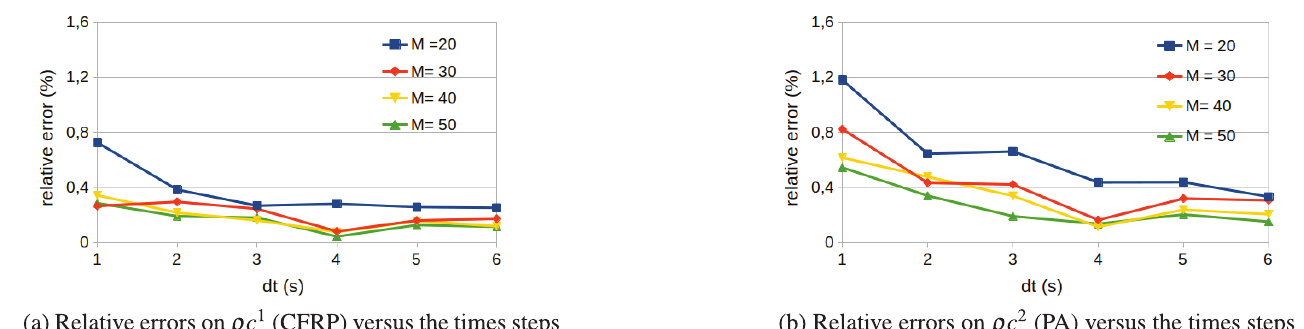
Fig. 8. Relative errors on the conductivity tensor with noise ( σ = 0 . 4 ◦ C) on the temperature fields for CRFP-PA material for several number of elements (M) along X and Y directions.